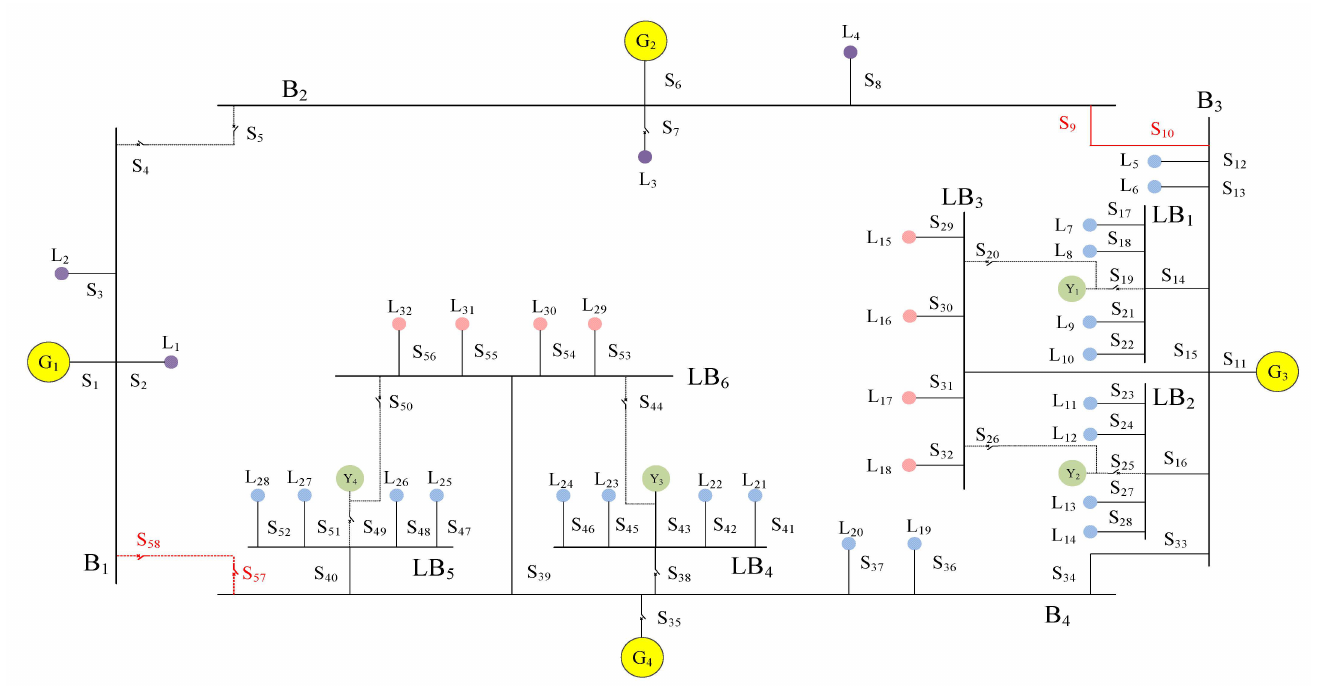
Figure 13. Convergence procedure of the MPGA under fault scenario 3.